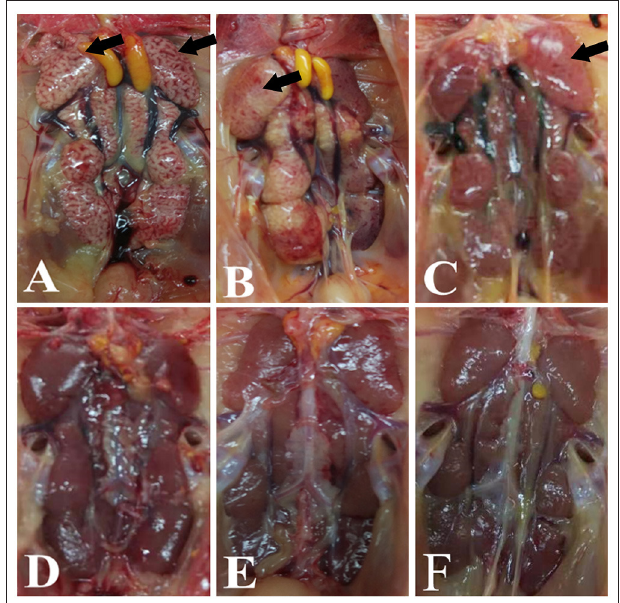
FIGURE 2 | Gross lesions in the kidneys. (A) IBV/H9N2 group, (B) IBV + H9N2 group, (C) H9N2/IBV group, (D) IBV group, (E) H9N2 group, and (F) control group. Black arrows point to the signs of a “spotted kidney”. IBV, infectious bronchitis virus.